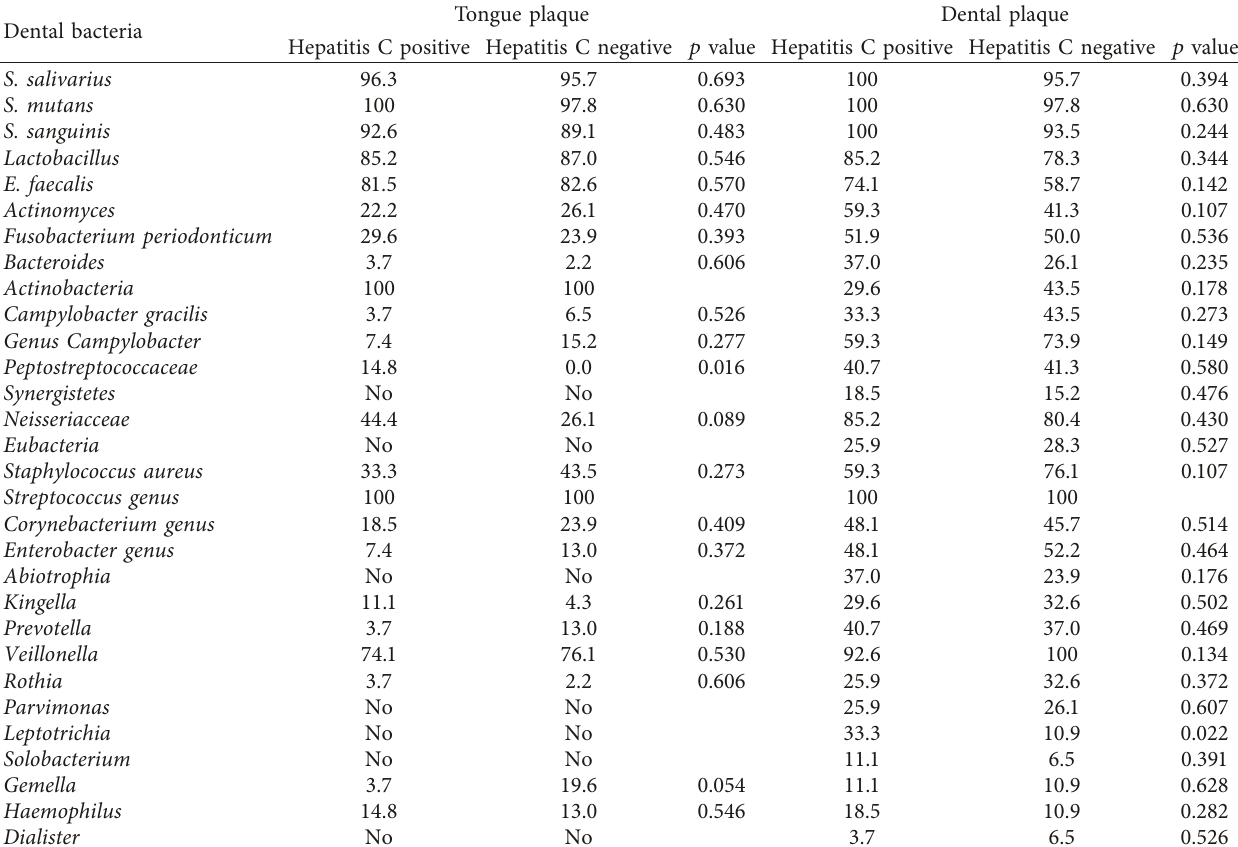
Table 3: The prevalence of the detected bacteria in patients with and without hepatitis C. Tongue plaque Dental Dental bacteria